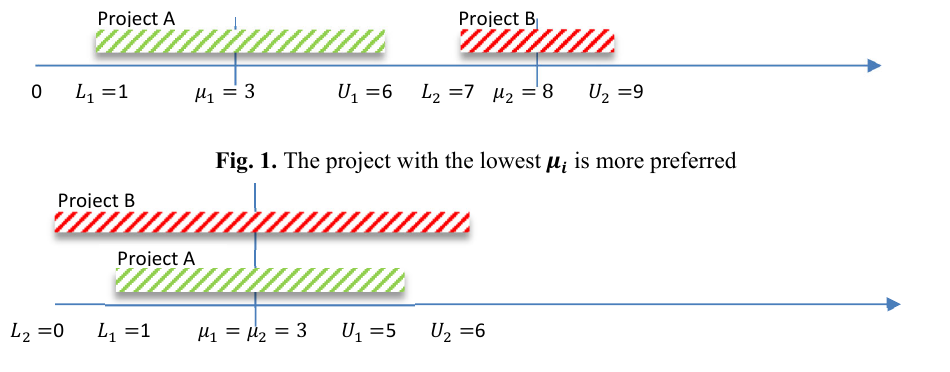
Fig. 2. While 𝝁 is equal for 2 alternatives, the alternative with lower 𝝈 𝒊